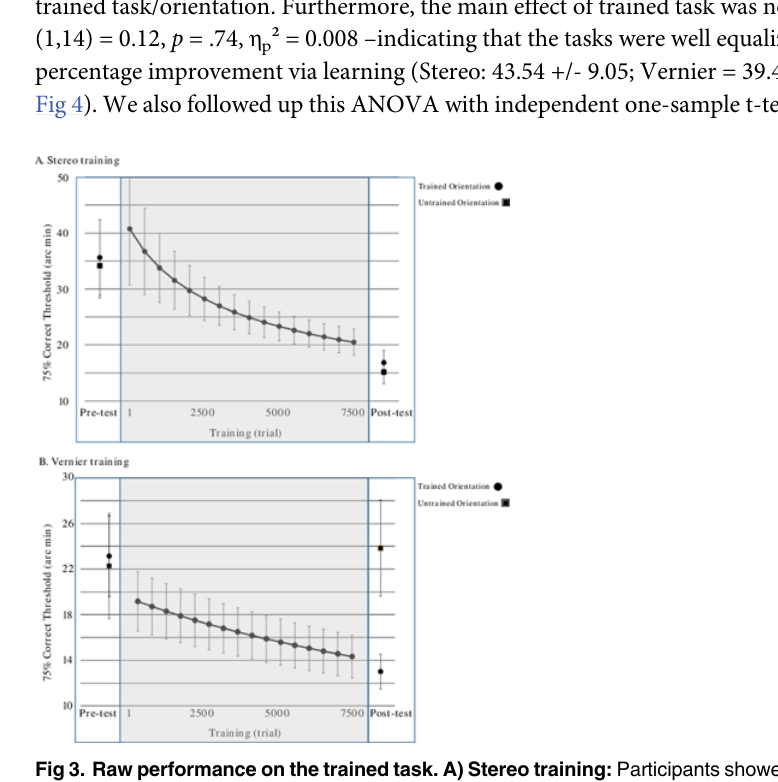
quantified below (see Results/Fig 4). * Error bars denote